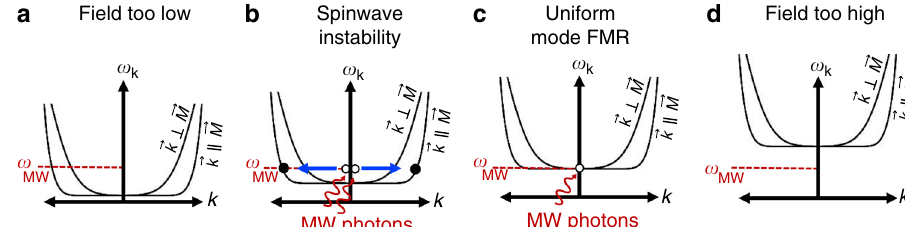
Fig. 2 Microwave absorption processes during in-plane magnetic fi eld sweep. a When the magnetic fi eld is well below the resonance condition microwaves do not ef fi ciently couple to the uniform FMR mode and there is no microwave absorption. b When the magnetic fi eld becomes close to the resonance condition, strong microwave drive can couple to the uniform mode FMR. In this process two microwave photons are absorbed at ω MW , giving two uniform mode magnons at ω MW with k = 0 (white circles) which then decay to a counterpropagating pair of magnons with the same energy, but nonzero- k (solid black circles). The microwave intensity threshold for this process is lowest for the ~ k k ~ M spinwave branch. The magnetic fi eld range for which this process occurs is microwave power dependent, resulting in a lineshape change at high microwave powers. c On resonance, the typical microwave excitation of uniform mode precession occurs. d When the magnetic fi eld exceeds the resonance condition there is no microwave absorption due to an absence of available magnon states at the microwave drive